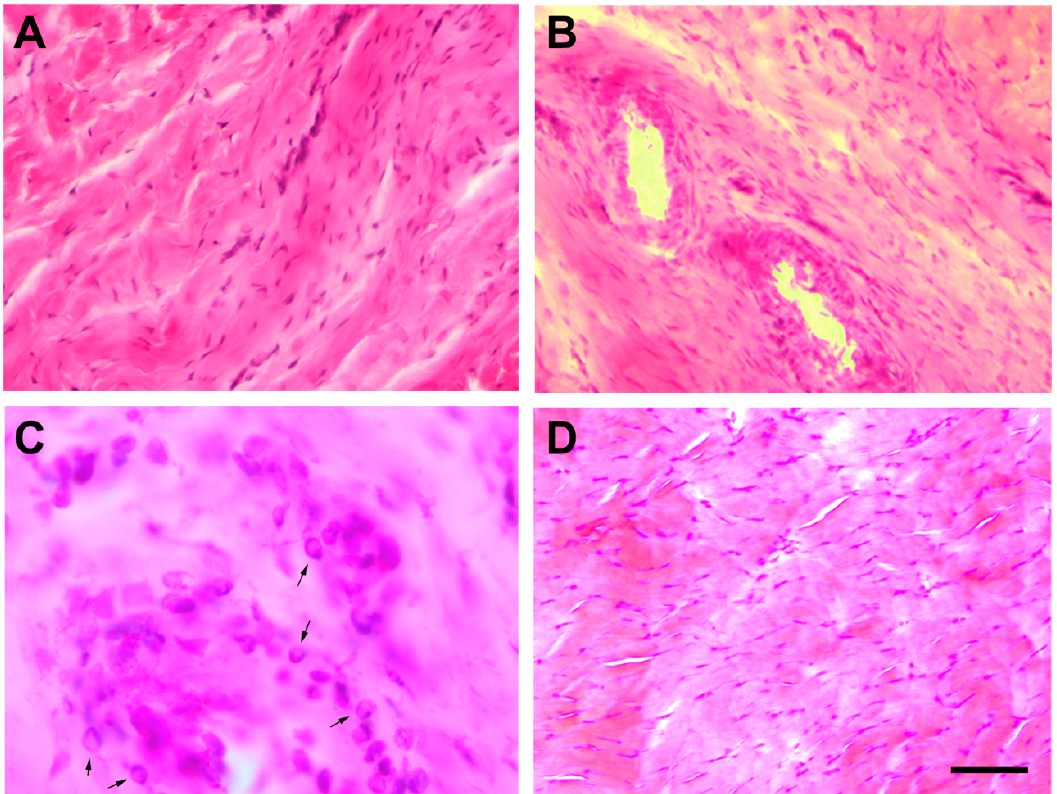
Figure 6. Stained longitudinal images with hematoxylin–eosin of injured Achilles tendon with collagenase injection by group: no intervention ( A ), treated with percutaneous electrolysis ( B , C ), or treated needling ( D ). Arrows in C shows several leucocyte cells. The scale bar is at 50 µ m ( A , B , D ) and 10 µ m ( C ).